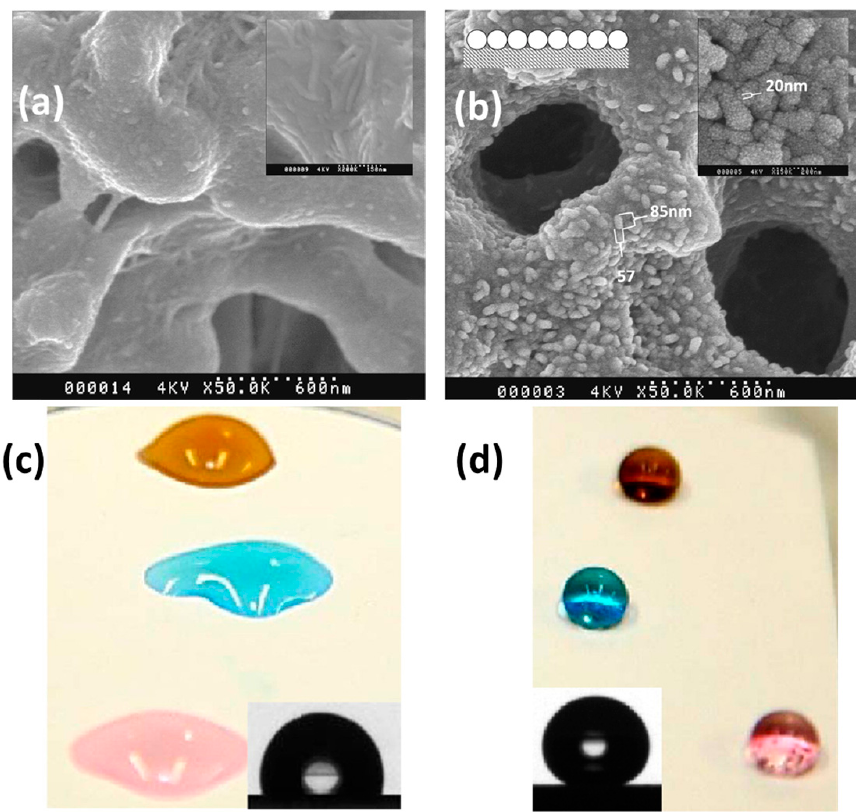
Figure 9. Effect of superhydrophobic modification on PVDF membranes: ( a ) virgin PVDF, ( b ) FTCS– TiO 2 –PVDF membrane (insets at the top right corner of ( a ) and ( b ) are the SEM images at high resolution and at the top left corner of ( b ) is the schematic side view of clusters assumed in a series of cylinders aligned horizontally). Wettability of PVDF membranes ( c ) before and ( d ) after modification with different aqueous solutions (insets: corresponding water contact angle image). Reprinted from [54]. Copyright (2012) with permission from Elsevier.